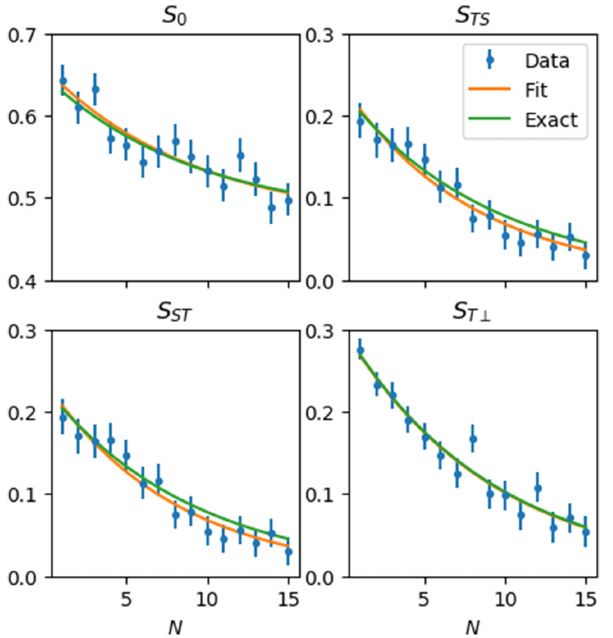
FIG. 2. The predicted and measured character-weighted sur- vival probability for a random error channel. The exact decay (green) is an exponential decay given by Eq. (11). We estimate S i ( N ) by applying random gates and measuring the final state (blue points). The data is fit to an appropriate function (orange) from which we estimate the fidelity.